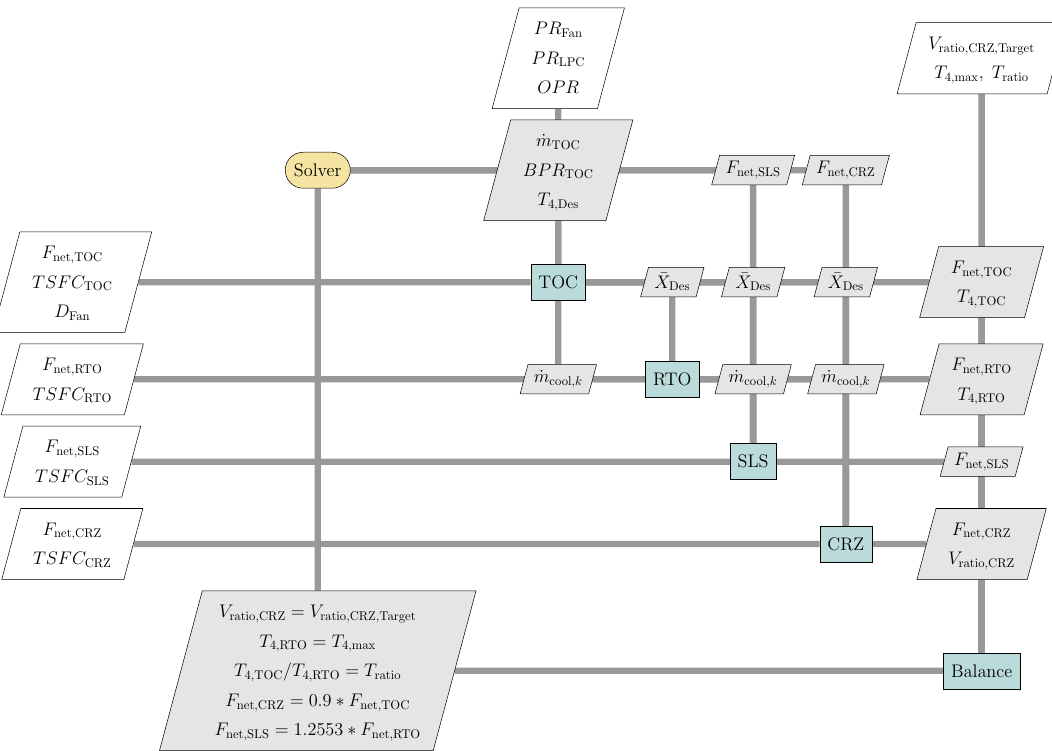
Figure 7. Reference engine model multi-design point